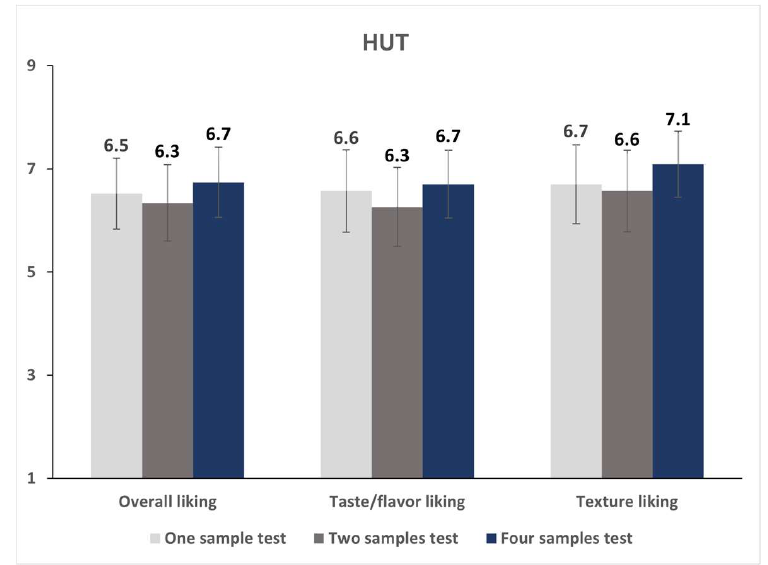
Figure 5. Mean liking scores of the almond beverage test target sample according to the number of evaluation samples in the home-used test condition. evaluation samples in the home-used test